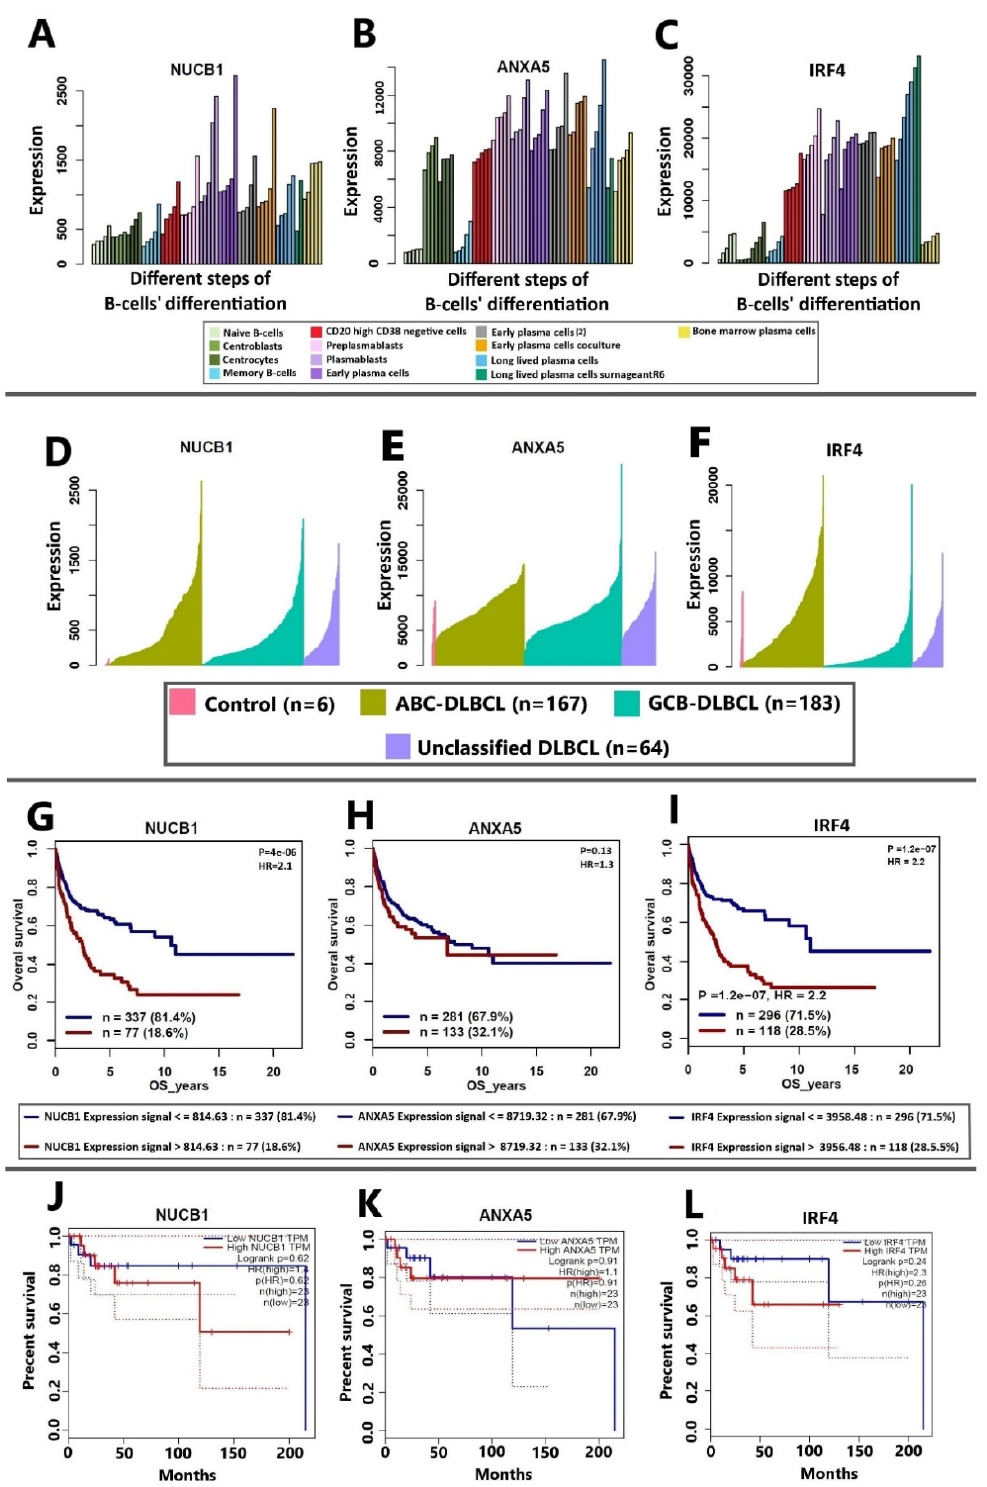
Figure 4. NUCB1, ANXA5, and IRF4 mRNA expression in B cell differentiation and survival analysis factored on mRNA expression. mRNA expression as fluorescence intensity summarized across probes for NUCB1 ( A ), ANXA5 ( B ), and IRF4 ( C ) in different stages of healthy B cells’ differentiation (as indicated in bottom legend). Gene expression of NUCB1 ( D ), ANXA5 ( E ), and IRF4 ( F ) in DLBCL subtypes. Overall survival plots obtained from Genomicscape factored on mRNA expression in DLBCL of NUCB1 ( G ), ANXA5 ( H ), and IRF4 ( I ). Percent survival plot generated by GEPIA based on factoring on mRNA expressions in DLBCL of NUCB1 ( J ), ANXA5 ( K ), and IRF4 ( L ).